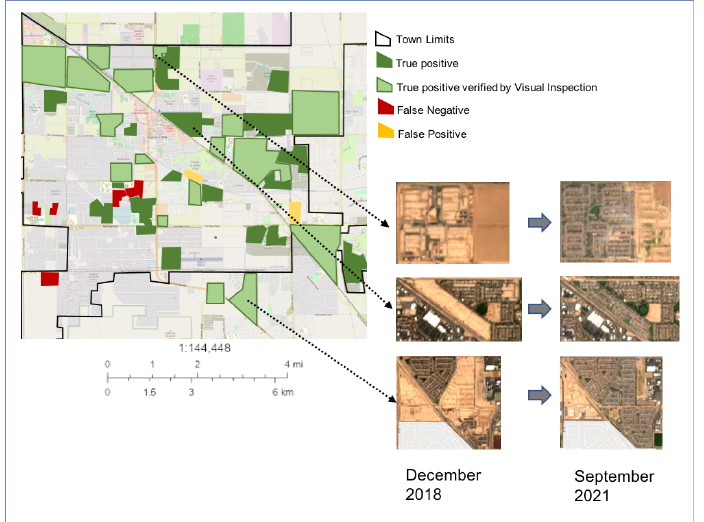
Figure 11. Comparison between change detection results and official documents of Queen Creek